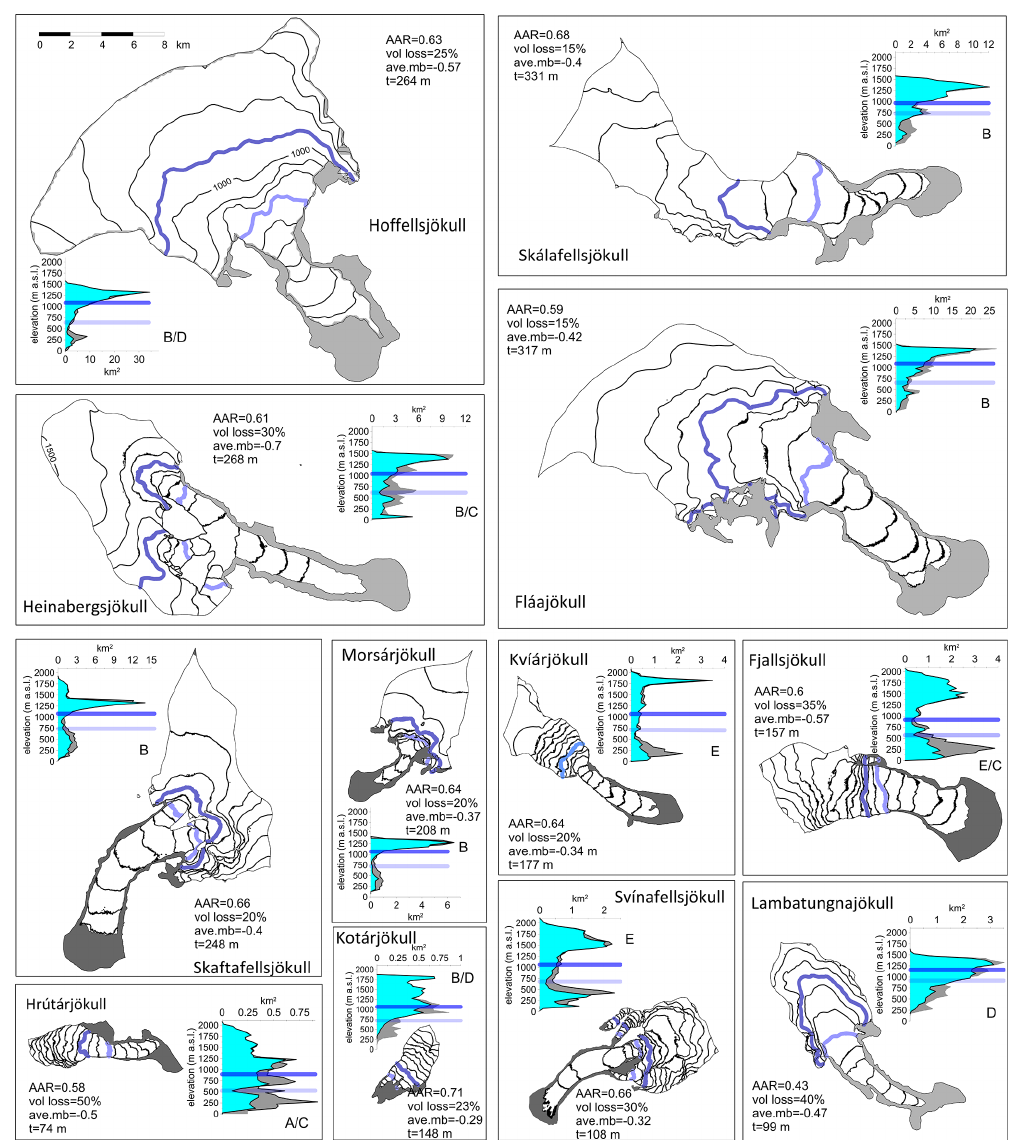
Figure 12. The topography of the outlet glaciers in 2010 with 100m contour lines of the lidar DEM. The ∼ 1890 areal extent is shown in dark grey for the Öræfajökull outlets and in light grey for the eastern outlets. The average MODIS-derived ELA (2007–2011) is drawn in dark blue on the map, and the inferred ELA of the maximum LIA in light blue (Hannesdóttir et al., 2014). Inset graphs show the 2010 area-altitude distribution of the glaciers (hypsometry) in 2010 (cyan) and ∼ 1890 (grey), with the average ELA for 2010 and ∼ 1890 shown in dark blue and light blue, respectively. The AAR, the relative volume loss of their ∼ 1890 size, the average geodetic mass balance ∼ 1890–2010 is shown in mw.e.a − 1 , as well as the average ice thickness ( t ) in 2010, for every